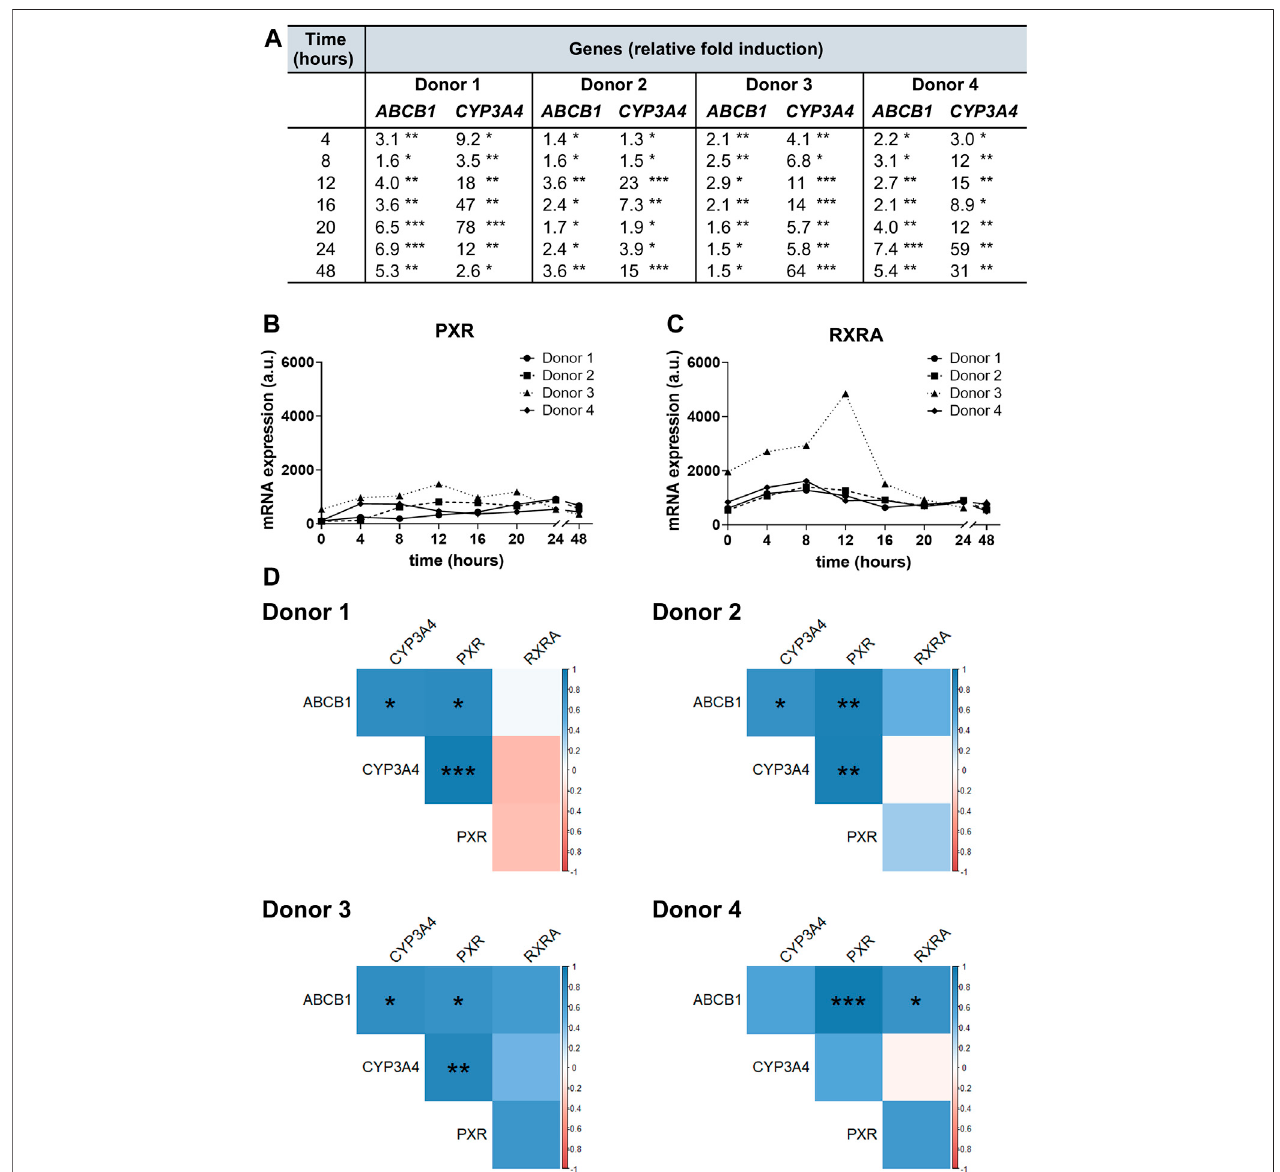
FIGURE 4 | ABCB1 , CYP3A4 , PXR , and RXRA gene expression in hPCIS determined by qRT-PCR. Fold changes in ABCB1 and CYP3A4 mRNA levels in hPCISs incubated with RIF (30 µM) for 4, 8, 12, 16, 20, 24, and 48 h (A) , relative to expression in RIF-free controls, showing that RIF signi fi cantly increased mRNA levels of both genesinsamplesfromalldonorsatalltested timepoints(one-sample t -tests,threeslicesfromonedonor:*, p < 0.05;**, p < 0.01;***, p < 0.001). PXR (B) and RXRA (C) weredemonstratedtobeexpressedinhPCISsincubatedwithRIF(30 µM)atalltestedtimepoints.AmountsofPXRandRXRAtranscriptsarepresentedinarbitrary units(a.u.),calculatedas2 − Δ Ct × 10 6 . (D) ThematrixofPearson ’ scoef fi cientsofcorrelationwasusedtoassessassociationsamongalltargetedtranscriptsinRIF-treated hPCISs (positive in blue and negative in red, with color intensity proportional to the magnitude of the coef fi cients). Asterisks indicate signi fi cant differences: *, p < 0.05; **, p < 0.01; ***, p < 0.001.